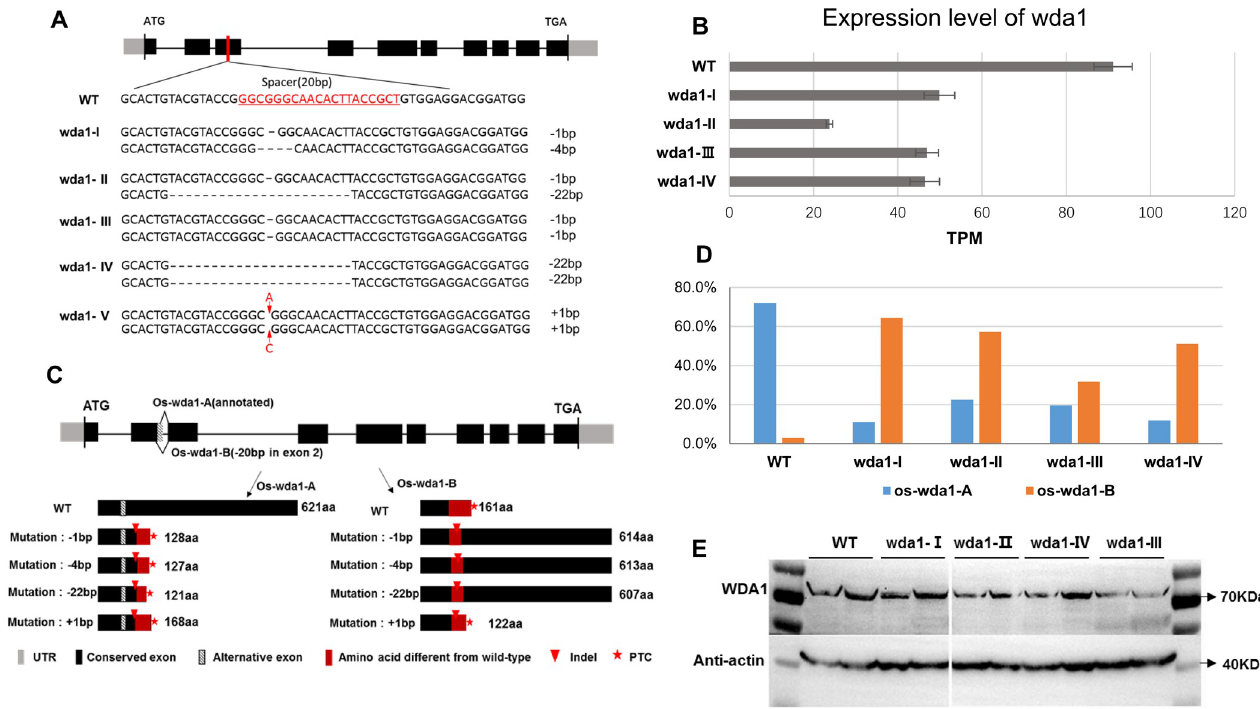
Fig 3. Genotype and alternative splicing isoforms in WT and mutants of wda1 . ( A ) Gene structure of wda1 and five different mutant genotypes. Mutants of wda1-I , II , III , IV cause a 3n+1-base deletion (n = 0 or a positive integer), wda1-V causes a one-base insertion (equivalent to a 3n+2 deletion). The grey box represents UTR, the black box represents CDS exon, the black line represents intron. ( B ) Expression of wda1 in WT and mutants. The X axis represents the sum TPM value of gene expression of all splice forms. Error bar stands for SEM.( C ) Two main splice forms of wda1 gene and the predicted effect of splice events on protein sequences. Os- wda1 -A means a transcript of the form specified by the canonical annotation, Os- wda1 -B is the new transcript that we detected with 20 bp deletion in exon2 compared with Os- wda1 -A. Mutants with 3n+1-base deletion (-1 bp, -4 bp, -22 bp) are expected to cause both premature termination and incorrect framing post the indel if splicing is in the transcript Os- wda1 -A mode, while a nearly full “wild-type” transcript will be expressed under the transcript Os- wda1 -B splicing mode. Mutant with 3n+2-base deletion (+1 bp) is expected to cause premature termination under the transcript Os- wda1 -A splicing mode and also under Os- wda1 -B mode. The grey box represents UTR, the black box represents conserved exon, the striped box represents an alternative exon region, and the red box represents amino acid sequence different from wild-type. Triangle represent s indel, asterisk indicates premature termination codon (PTC). ( D ) Proportion of the two alternative splicing isoforms (Os- wda1 -A, Os- wda1 -B) detected by TA cloning. ( E ) Western blots of protein WDA1 in wild-type and mutant homozygotes. The predicted weight of full-length WDA1 protein is 71.2 kDa, anti-actin is 42 kDa. The results showed that through the splicing isoforms of Os- wda1 -B, nearly full-length protein of WDA1 was produced in the CRISPR knockout lines of wda1 - I , II , III and IV .